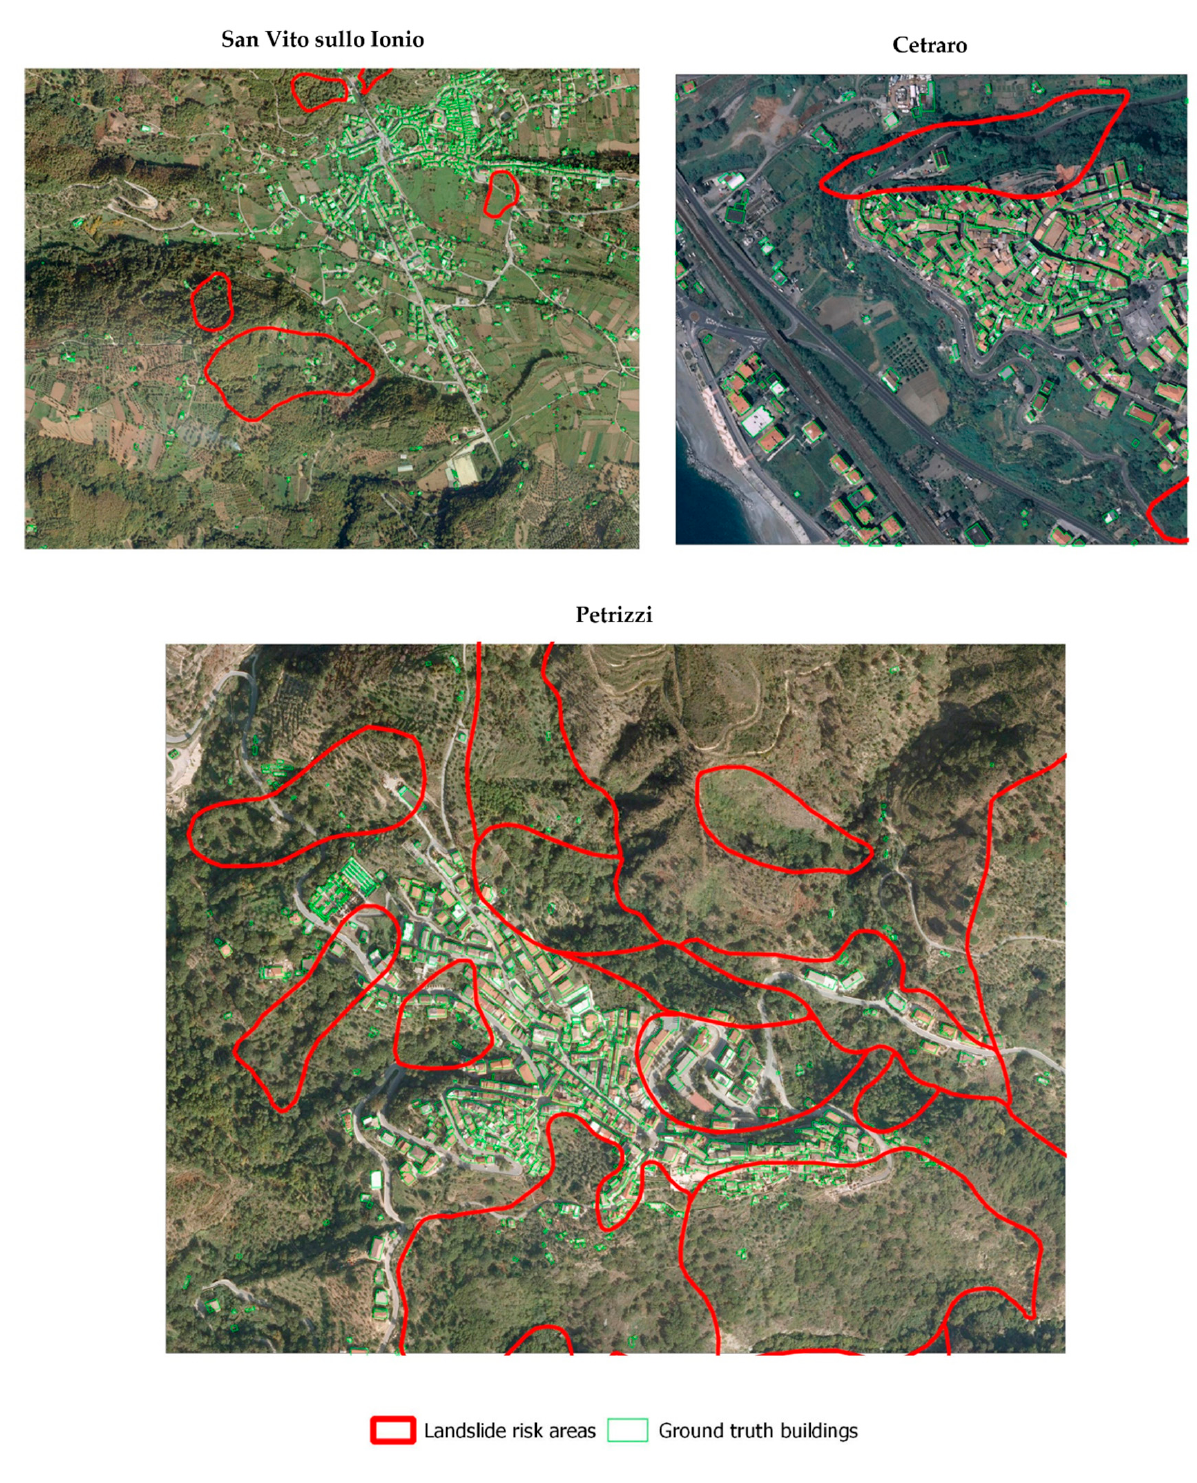
Figure 3. Ground truth dataset.